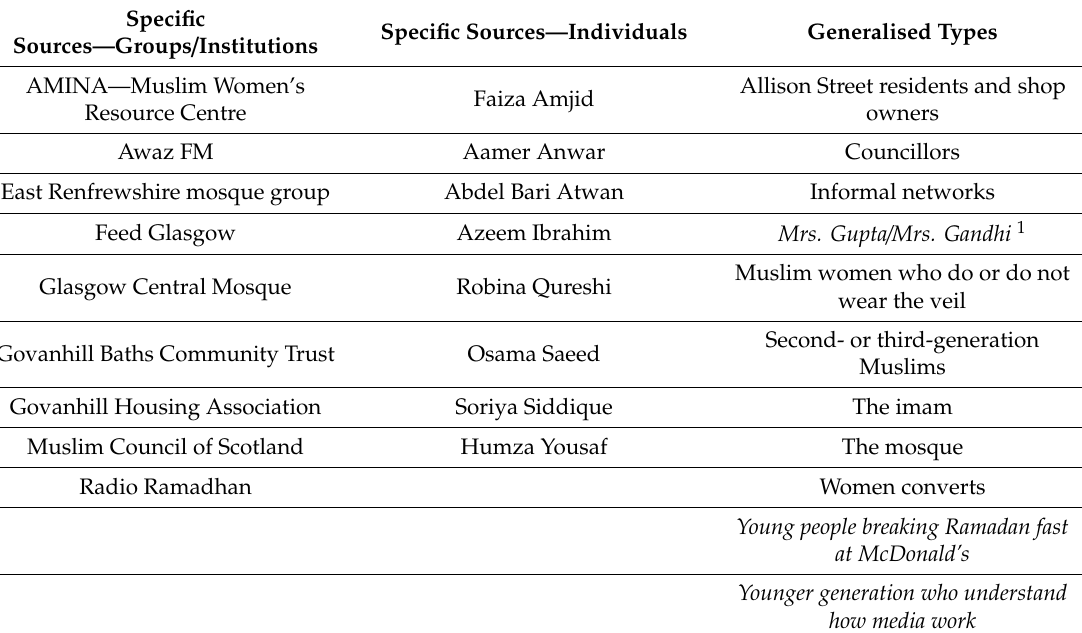
Table 1. Muslim sources mentioned by journalists in Glasgow,